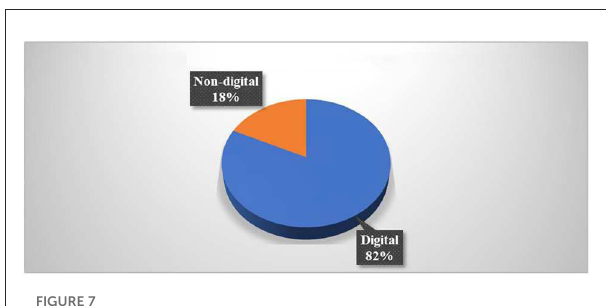
FIGURE7 The number of articles based on the type of game